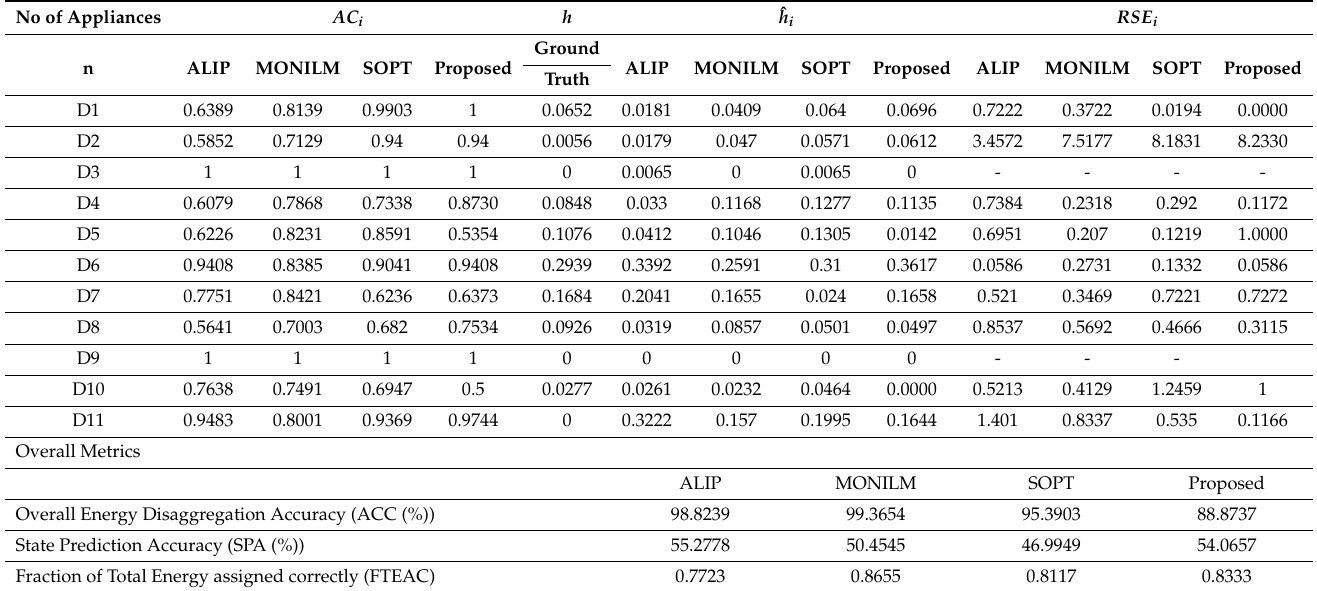
Table 7. Comparison of the proposed framework with state-of-the-art methods in terms of energy disaggregation in the I 18 problem